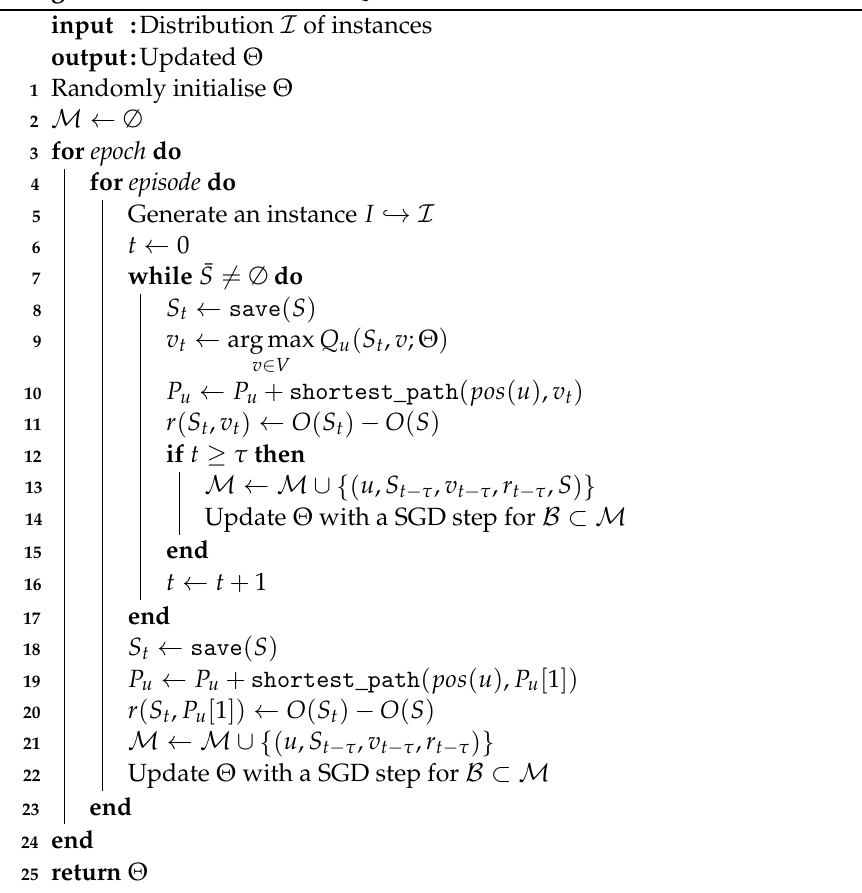
Algorithm 2: Pseudo-code of